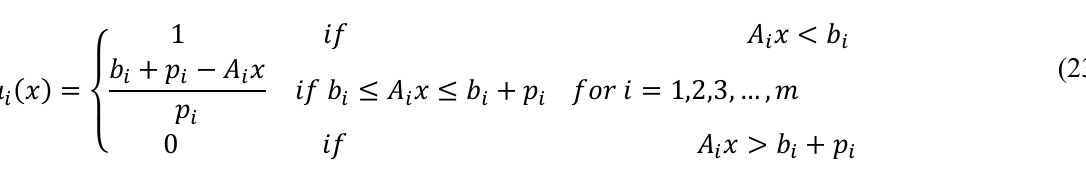
Fig. 3. Fuzzy resource with tolerance (cid:1868)